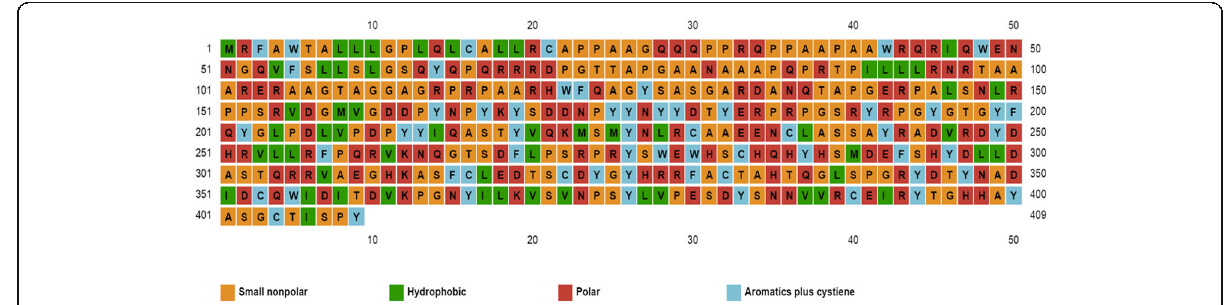
Fig. 3 Secondary structure prediction using SWISS-MODEL. Thirty-eight percent of total amino acids were non-polar, 34% were polar, 14% were hydrophobic, and 14% contributed to aromatic plus cysteine